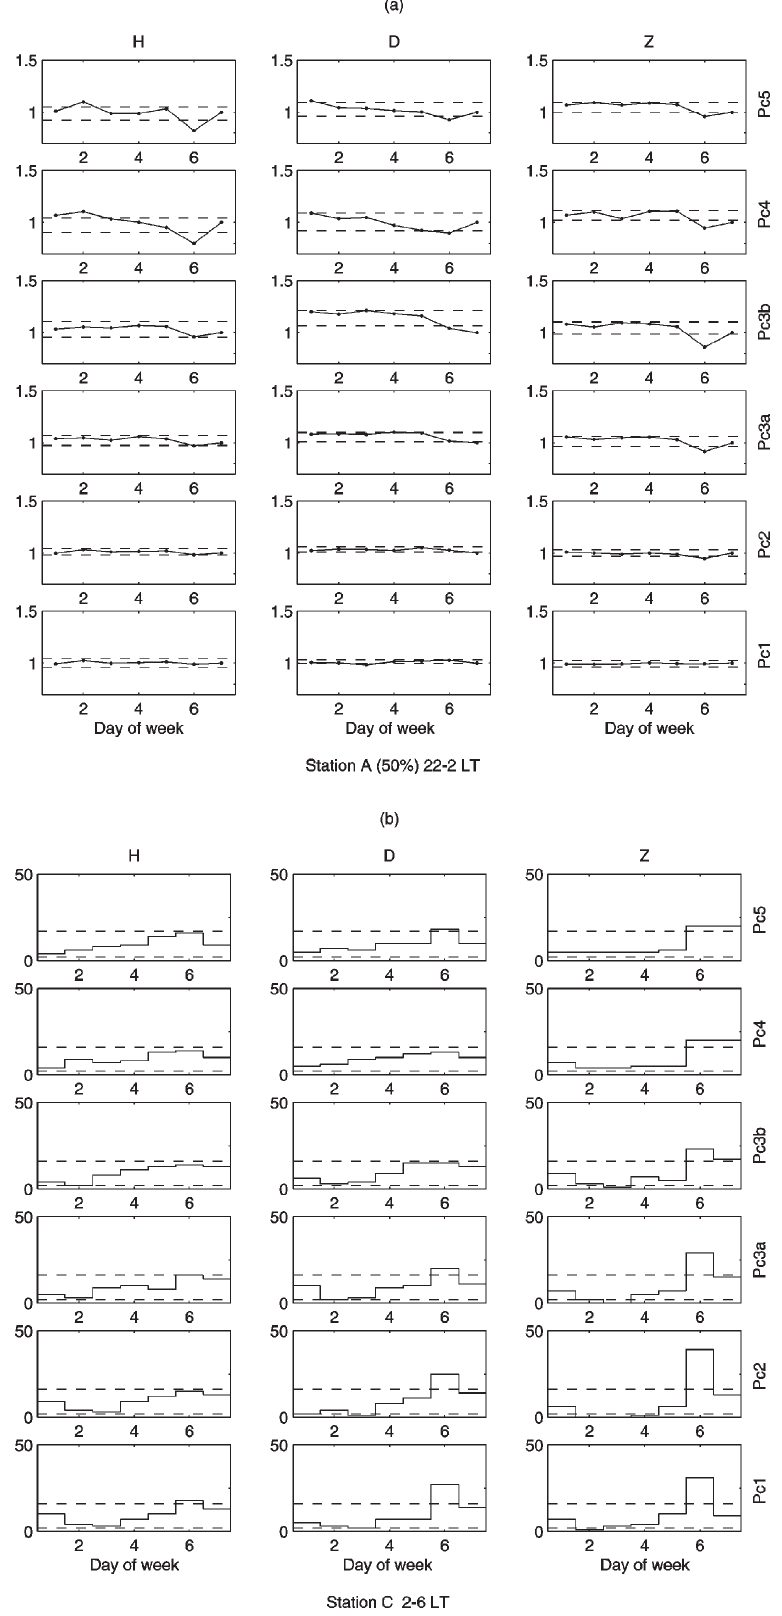
Fig. 6. (a) Weekly variation of the average power (22–2LT) of magnetic field components in different frequency bands at Station A (50% of original spectra). (b) Weekly distribution of the lowest values of power (5% of the whole population) in different frequency bands at Station C